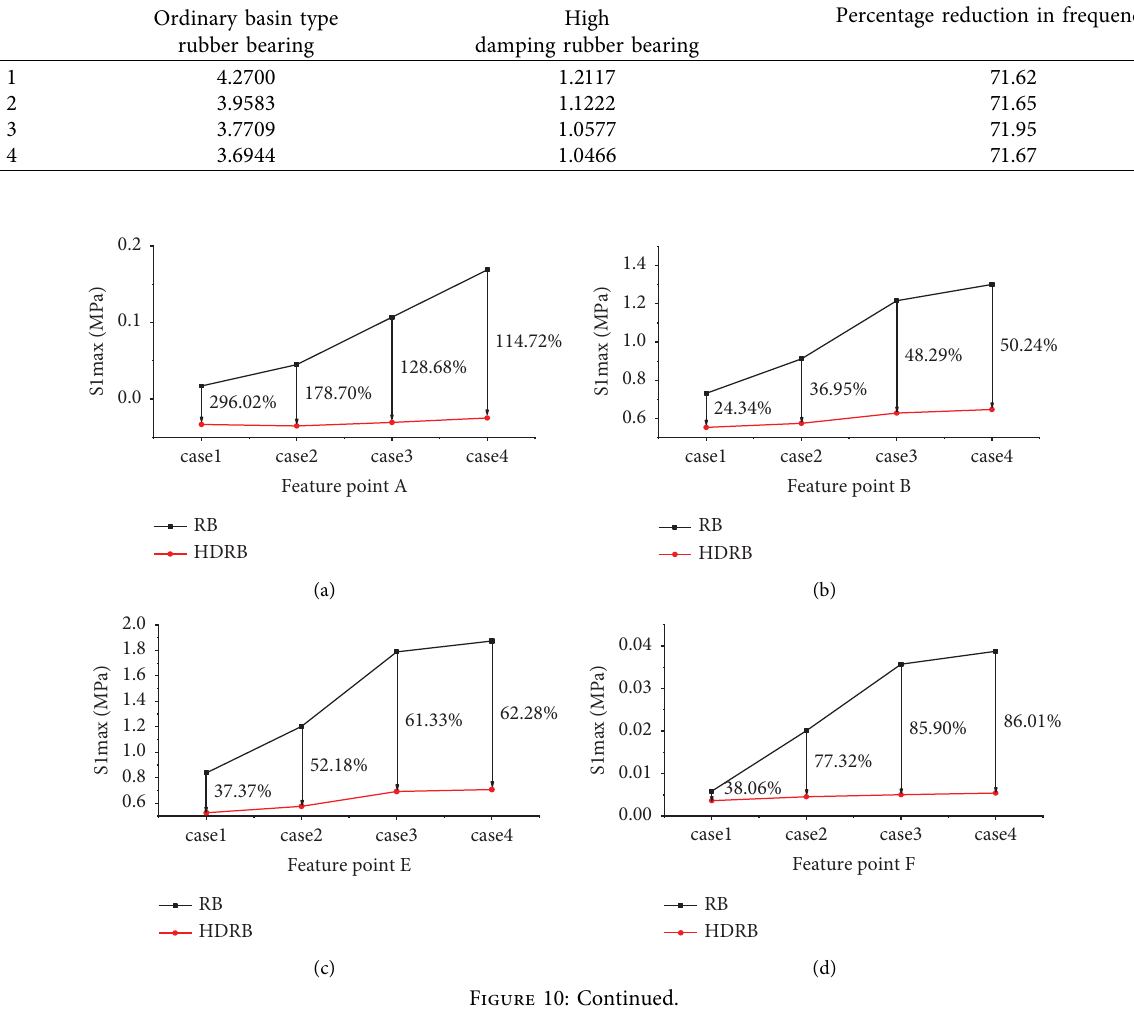
Percentage reduction in frequency (%)Ordinary basin type